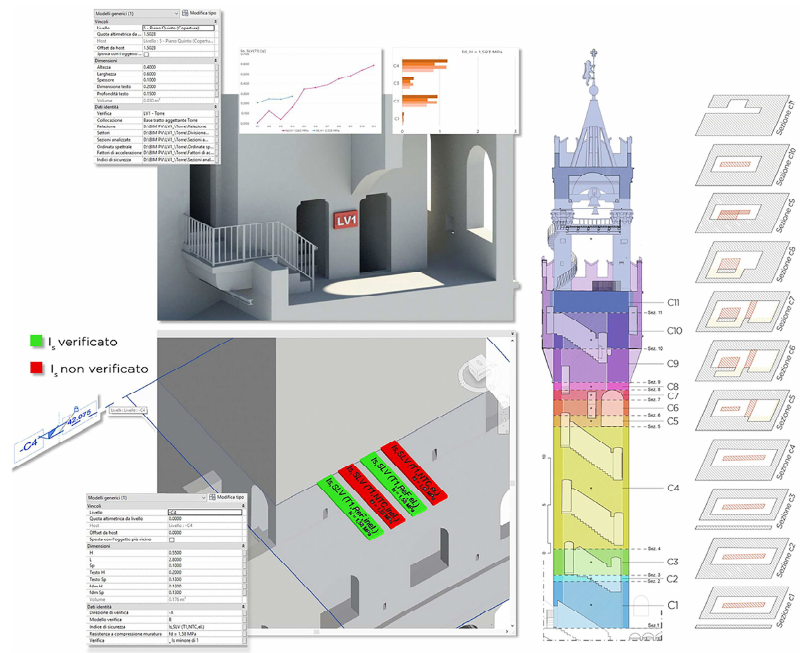
Figure 11. LV1 assessment for the Arnolfo’s Tower. The results are implemented in the H-BIM da- tabase. On the right, the di ff erent structural sections considered in the veri fi cation of the perfor- mances. On the right, the different structural sections considered in the verification of the